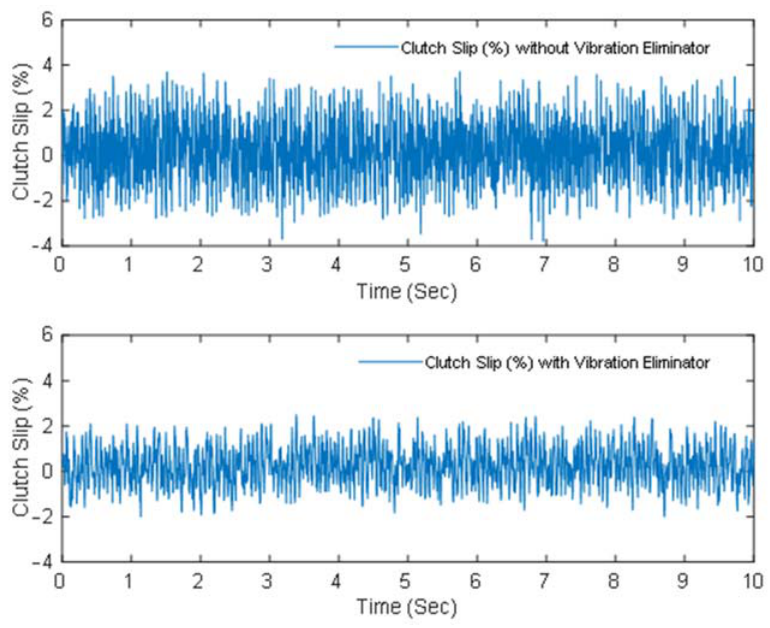
Figure 16. Vibration before and after pressure regulation.